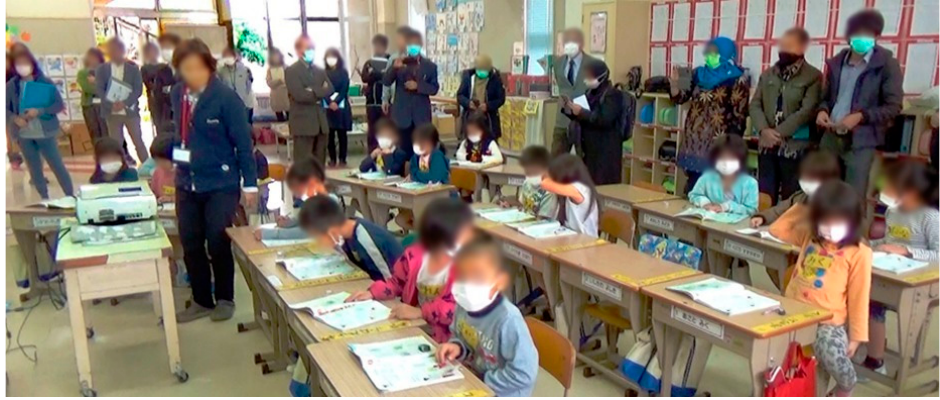
Figure 2. A lesson study: Participants and students wear masks to avoid COVID ‐ 19 infection.